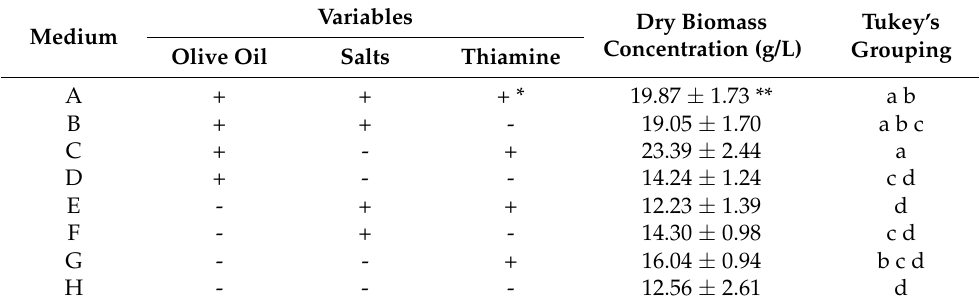
Table 2. Dry biomass concentrations in treatments evaluated for optimization of the culture medium.